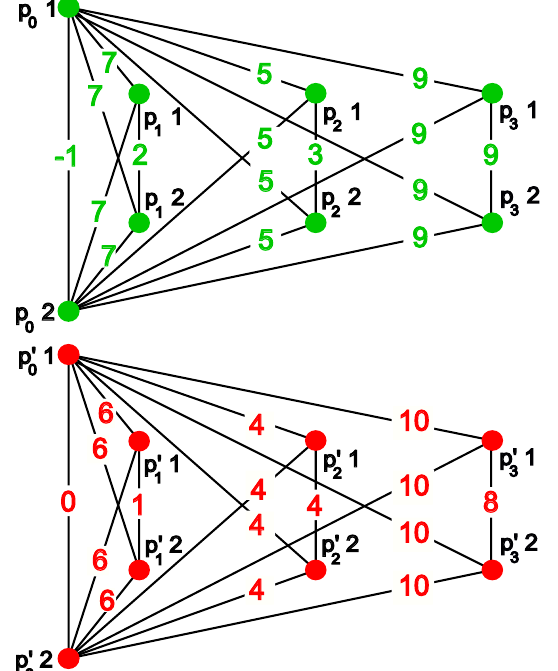
Figure 5. The weighted graphs whose natural pseudodistance equals the bottleneck distance of the persistence diagrams of Figure 2, relative to the persistence function p c 2 . Above (resp. below), the weighted graph corresponding to the green (resp. red) persistence diagram and to the upper (resp. lower) Hasse diagram of Figure